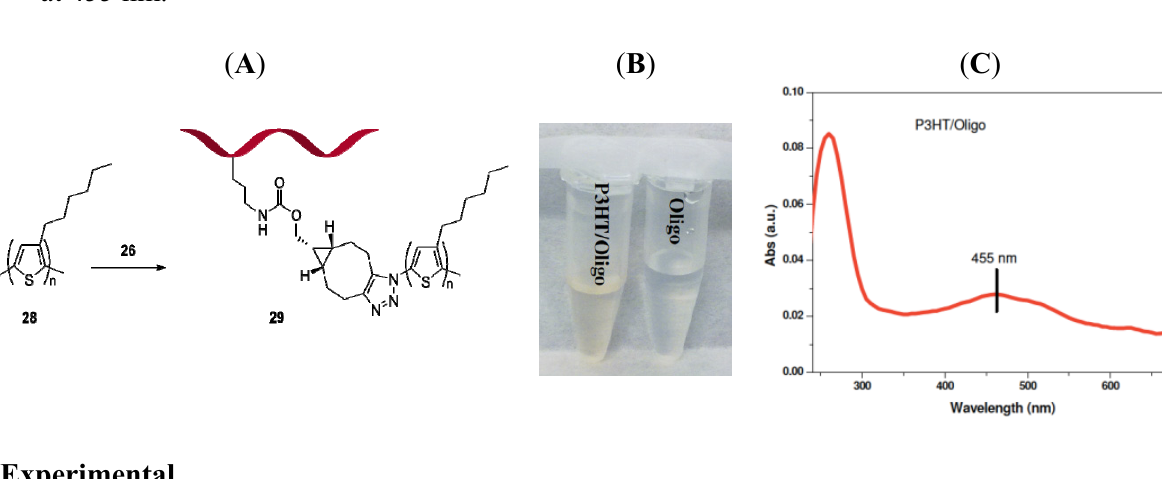
Figure 3. ( A ) Conjugation of azido-terminated P3HT 28 and BCN-containing oligonucleotide 26 leading to 29 . ( B ) Aqueous solution of 28 turns yellow as a consequence of spontaneous (3+2) cycloaddition leading to solubilization. ( C ) UV-VIS spectrum of aqueous solution shows the appearance of the typical absorption band of P3HT at 455